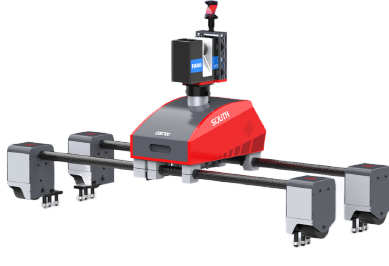
Figure 7. MS100 3D